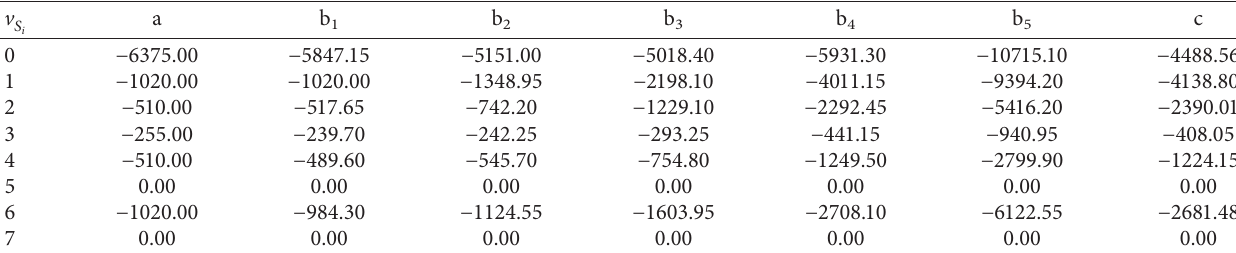
Table 6: States’ value of the different trip chains of different groups.